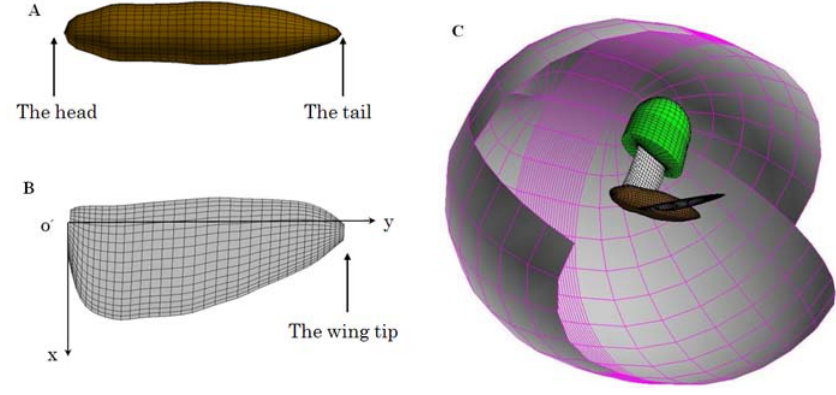
Fig. 1. Grid systems of the body (A), the wing (B), and the wing-body moth model